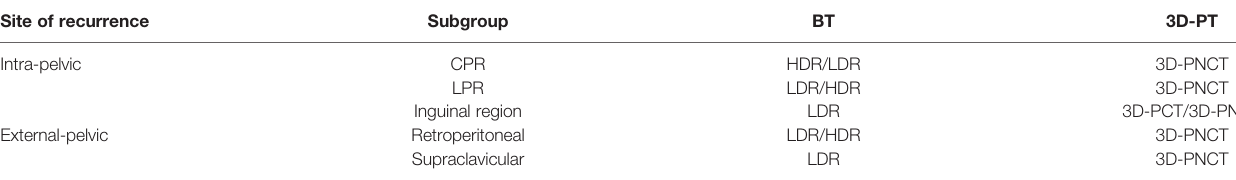
TABLE 2 | BT and 3D-PT selection according to rCC classi fi